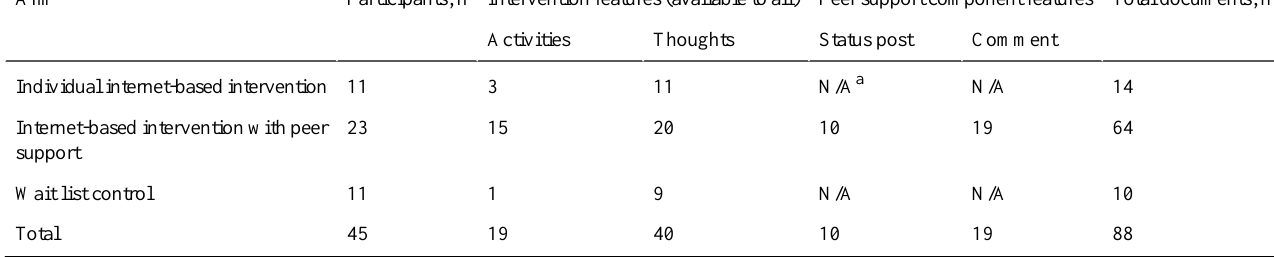
Table 3. Textual data used in qualitative data